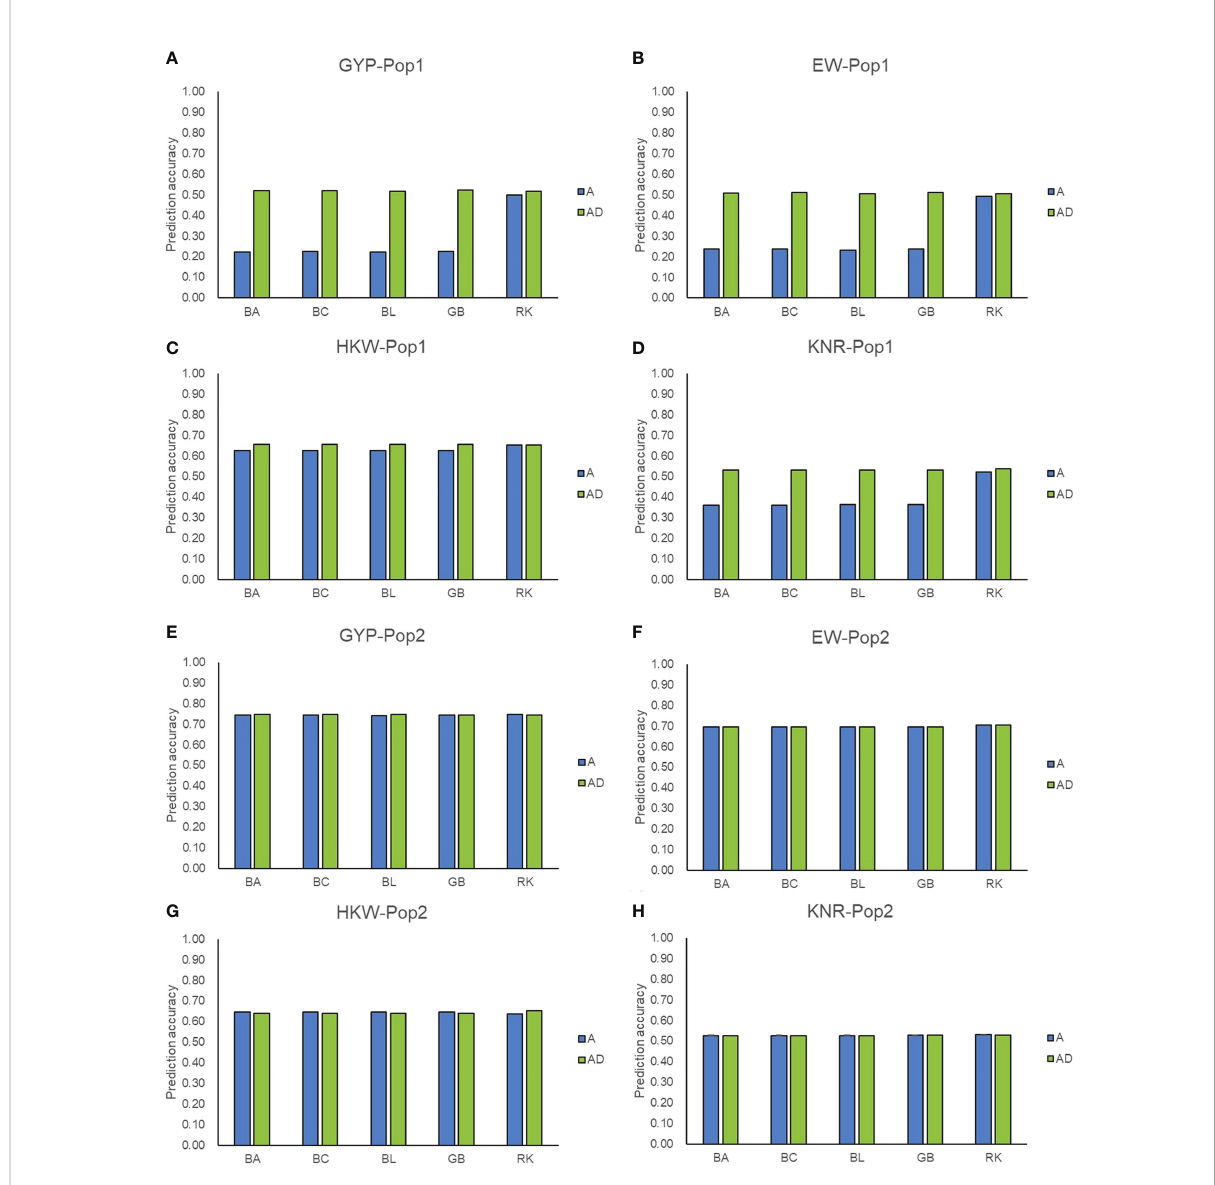
FIGURE 4 Accuracy of additive and additive-dominance model predicting hybrid performance. (A – D) represent the prediction accuracy for GYP, EW, HKW, and KNR in Pop1, respectively. (E – H) represent the prediction accuracy for GYP, EW, HKW, and KNR in Pop2, respectively. A and AD represent additive and additive-dominance model,